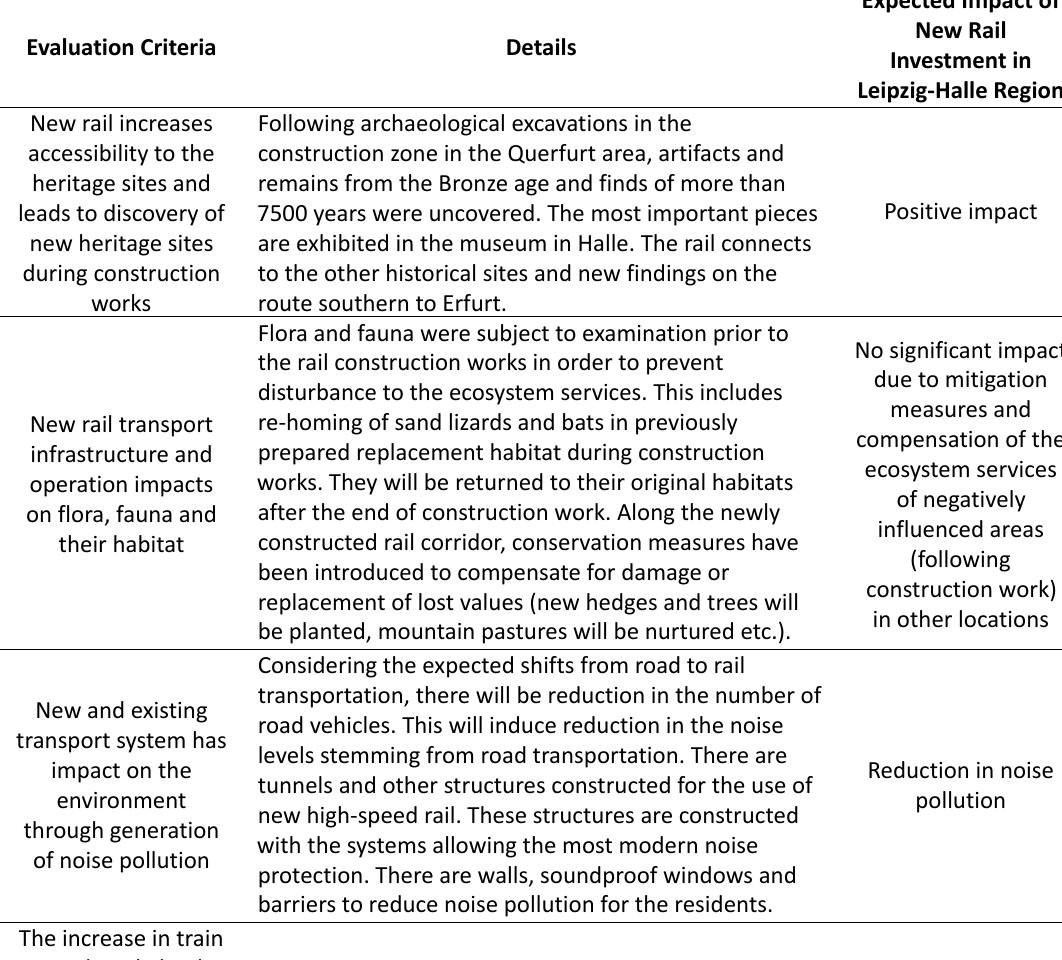
Table 7. Qualitative assessment of selected impacts and indicators for the Leipzig-Halle Region. (Cont.)